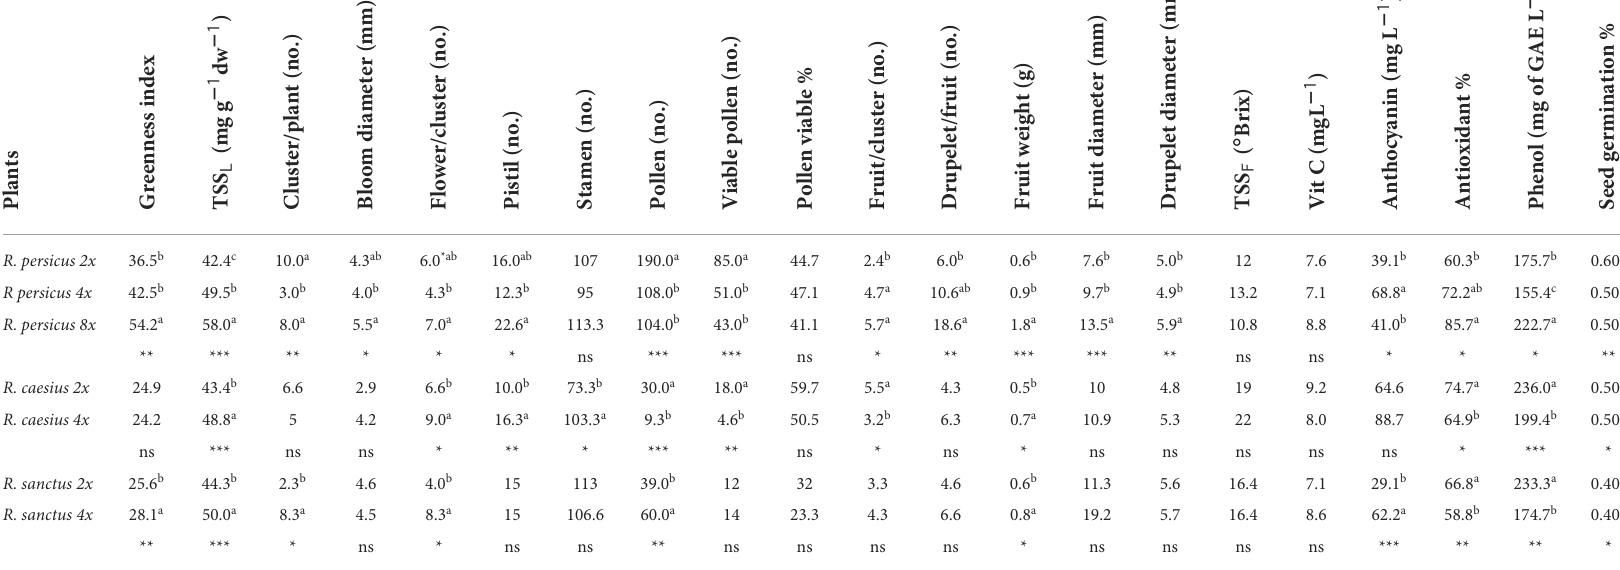
TABLE 2 The mean comparison of leaf, flower, and fruit’s morphological and biochemical characteristics between diploid and polyploid plants of three blackberry